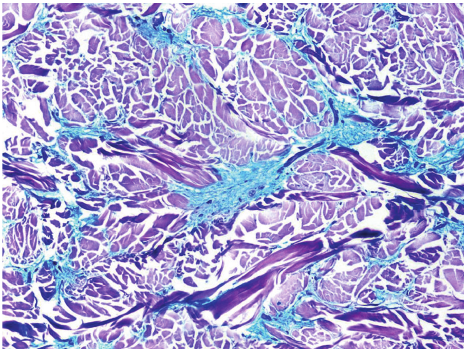
Figure 2: Histological aspect of skin biopsy. Blue Alcian dye. Thickened dermis and increased accumulation of aminoglycans between large collagen